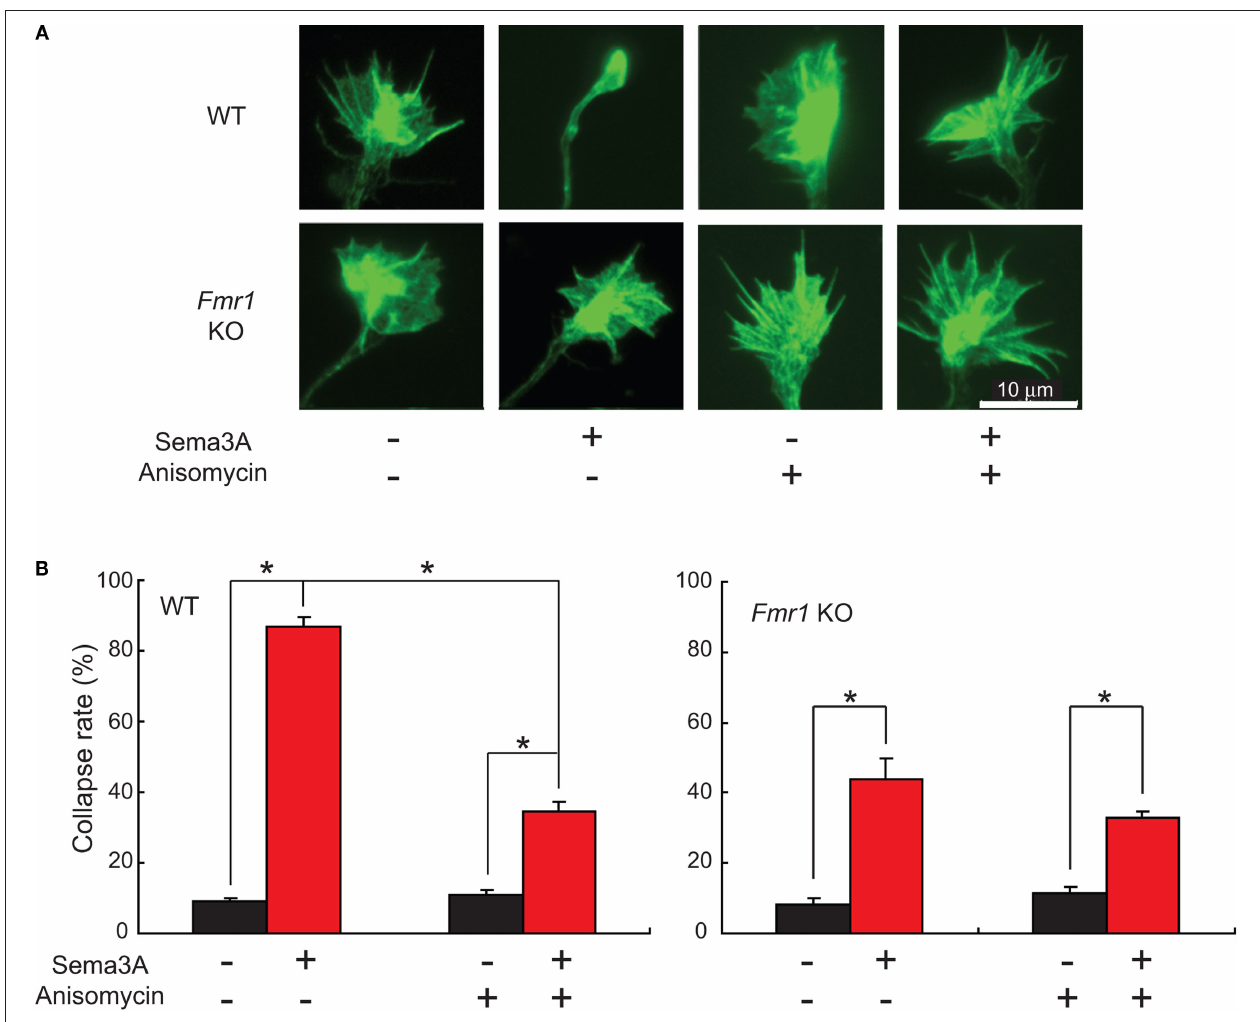
FIGURE 1 | Sema3A-induced growth cone collapse is attenuated in Fmr1 KO neurons, which fail to exhibit protein synthesis-dependence. (A) Response of growth cones to Sema3A (1 nM, 30 min) with or without a protein synthesis inhibitor, anisomycin, in wild type (WT) and Fmr1 knock-out (KO) hippocampal neurons. Alexa488-phalloidin staining of F-actin in growth cones is shown. (B) Rate of growth cone collapse of WT ( left ) and Fmr1 KO